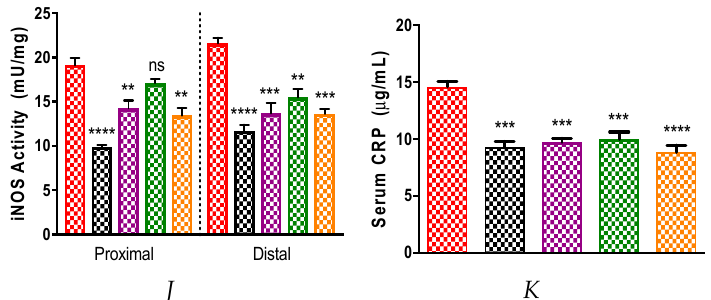
Figure 5. Effect of B. coagulans spores, PSCF and synbiotic on immune markers in colon tissues and blood serum. Protein levels of cytokines including ( A ) IL-1 α , ( B ) IL-1 β , ( C ) IL-6, ( D ) IL-12, ( E ) TNF- α , ( F ) IFN- γ in proximal and distal colon explants as well as cytokine levels of ( G ) IL-1 β , ( H ) IL-10, and ( I ) IL-12 in blood serum were analysed by Bio-plex. iNOS activity in colon tissues ( J ) measured by NOS activity assay and CRP levels in serum ( K ) by ELISA. Statistical significance among groups evaluated by one-way ANOVA followed by Tukey’s test. * p < 0.05, ** p < 0.01, *** p < 0.001, **** p < 0.0001 vs. DSS-colitic group and data expressed as mean ± SEM ( n = 3 per group).